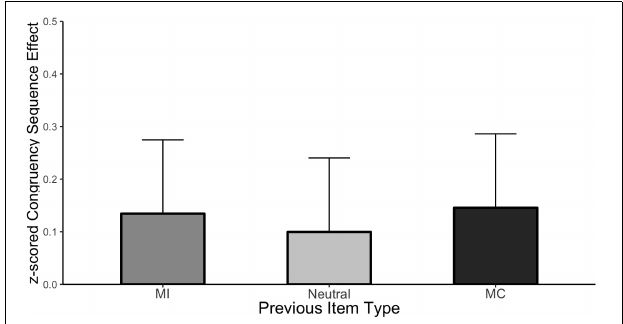
there was an ISPC). Specifically, relative to the neutral condition, interference was greater for the MC items (Mean effect = 0.256, HDI = 0.069:0.441) and was smaller for the MI items (Mean effect = − 0.269, HDI = − 0.454: − 0.082). Thus, the ISPC effect is readily apparent even under these highly controlled conditions.